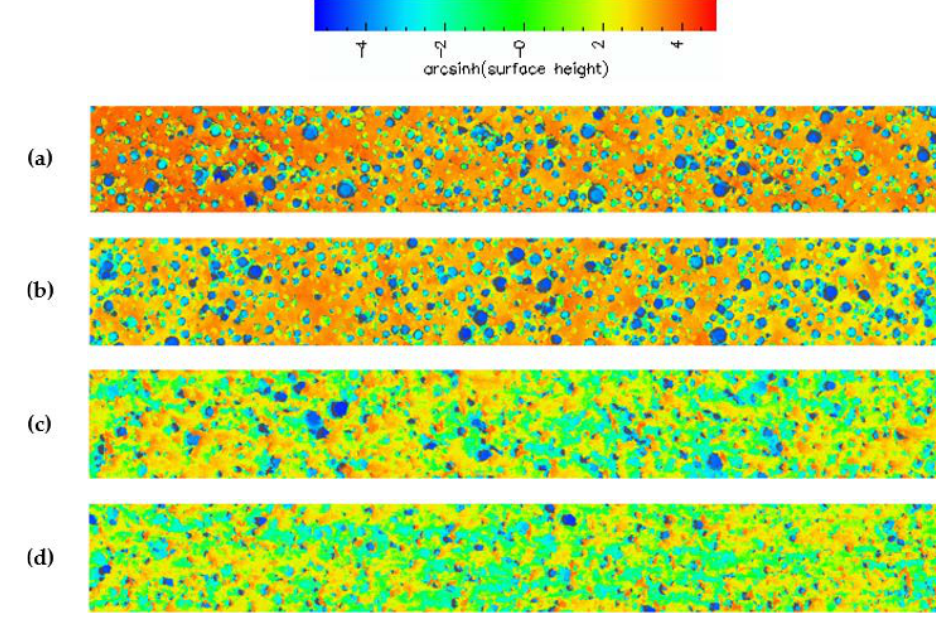
Figure 2. Surface topography of ( a ) brand-new pad; followed by pads broken-in for 30 min with ( b ) EHWA disc at 2.7 kg f , ( c ) ABT disc at 2.7 kg f and (d) ABT disc at 0.9 kg f .